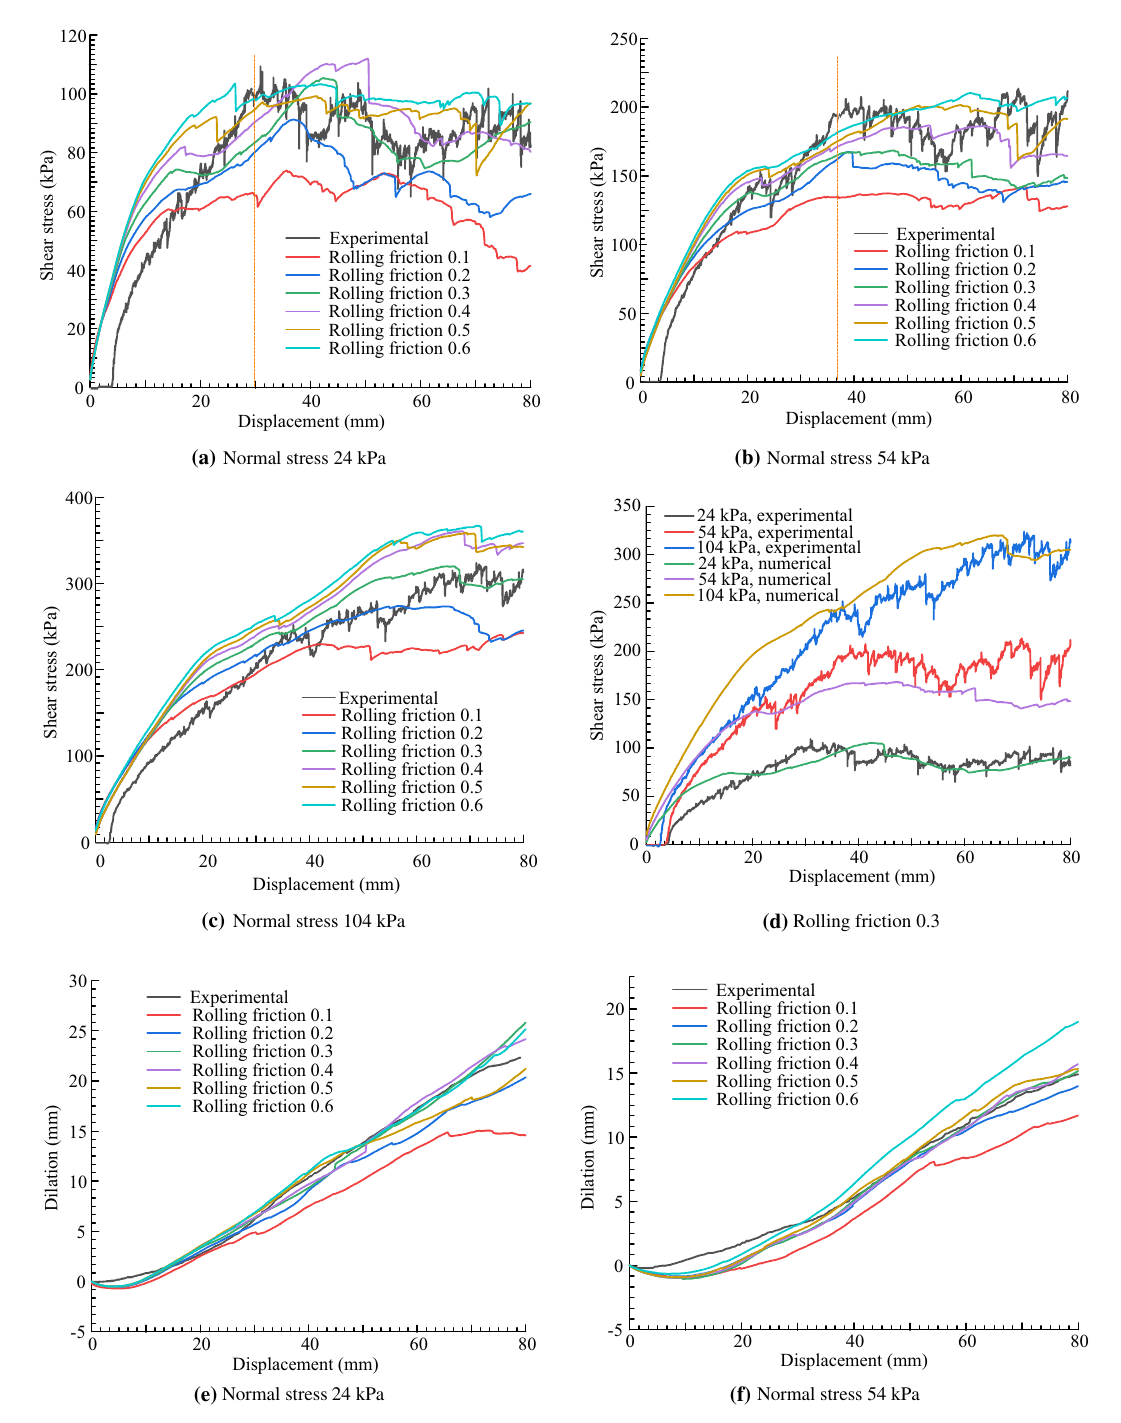
Fig. 5 Shear stress and dilation results of the DST simulation under the normal stress of 24, 54 or 104